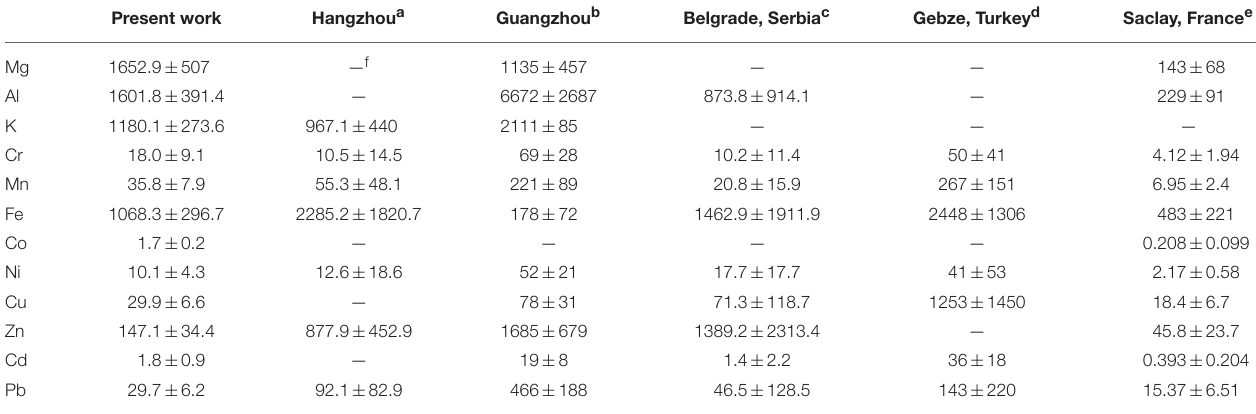
TABLE 1 | Concentration of airborne particulate-bound trace elements in TSP of Shanghai, and other cities (mean ± SD, ng/m 3 ). Present